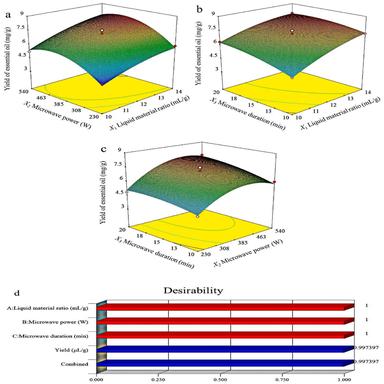
Key factors for BBD optimization. Interaction of liquid material ratio and microwave power (a); interaction of liquid material ratio and microwave duration (b); and interaction of microwave power and microwave duration (c); the bar graph of experimental parameters under optimal conditions (d).